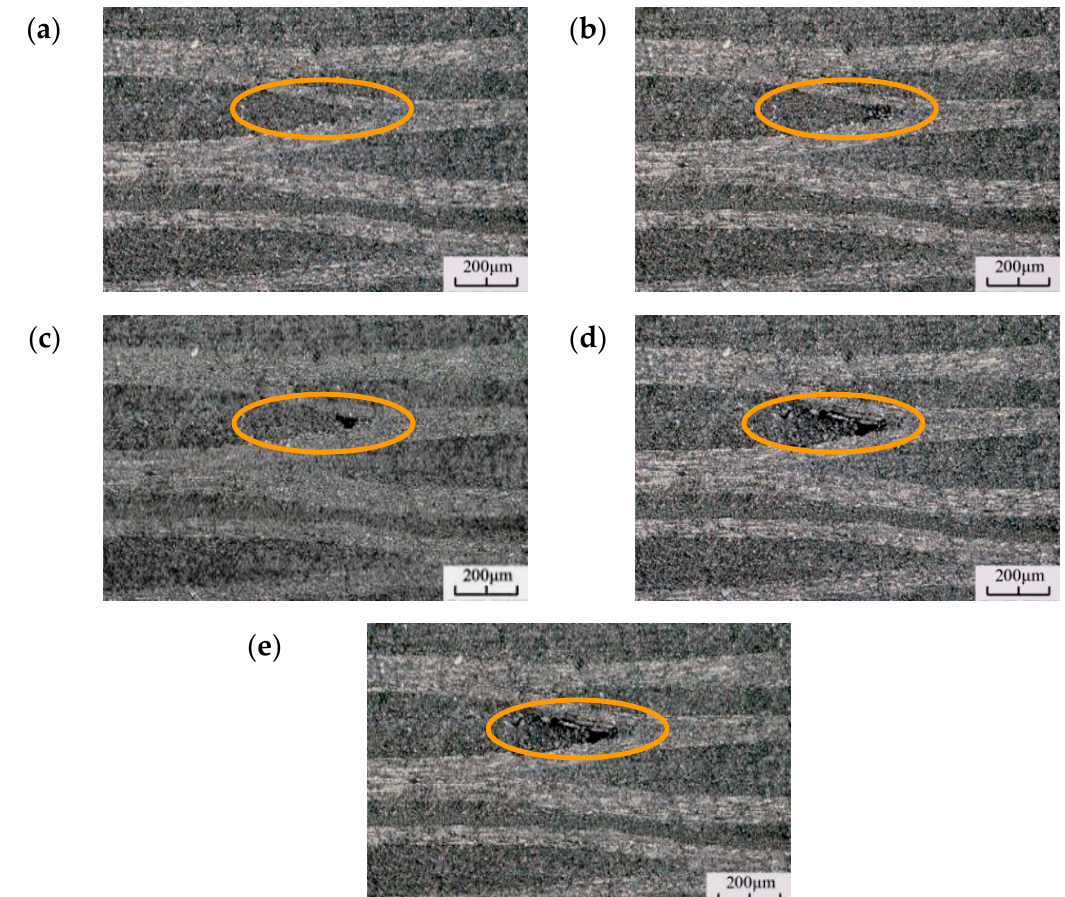
Figure 14. Evolution and expansion of the pitting morphology for ( a ) N = 6.0 × 10 7 , f = 20,130 Hz, ( b ) N = 8.9 × 10 7 , f = 20,126 Hz, ( c ) N = 9.7 × 10 7 , f = 20,118 Hz, ( d ) N = 2.5 × 10 8 , f = 20,105 Hz, and ( e ) N = 3.8 × 10 8 , f = 20,086 Hz.